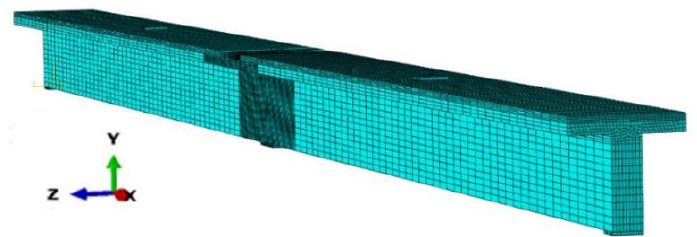
Figure 7. Schematic of the main beam mesh.